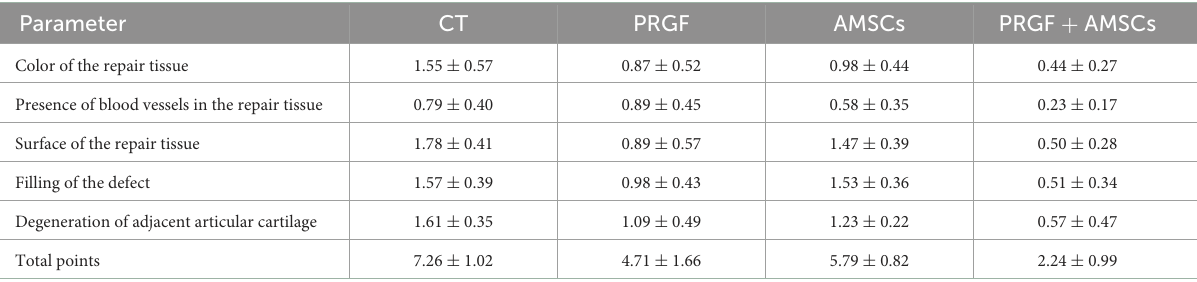
TABLE 4 Macroscopical scores 84 days after infiltration.